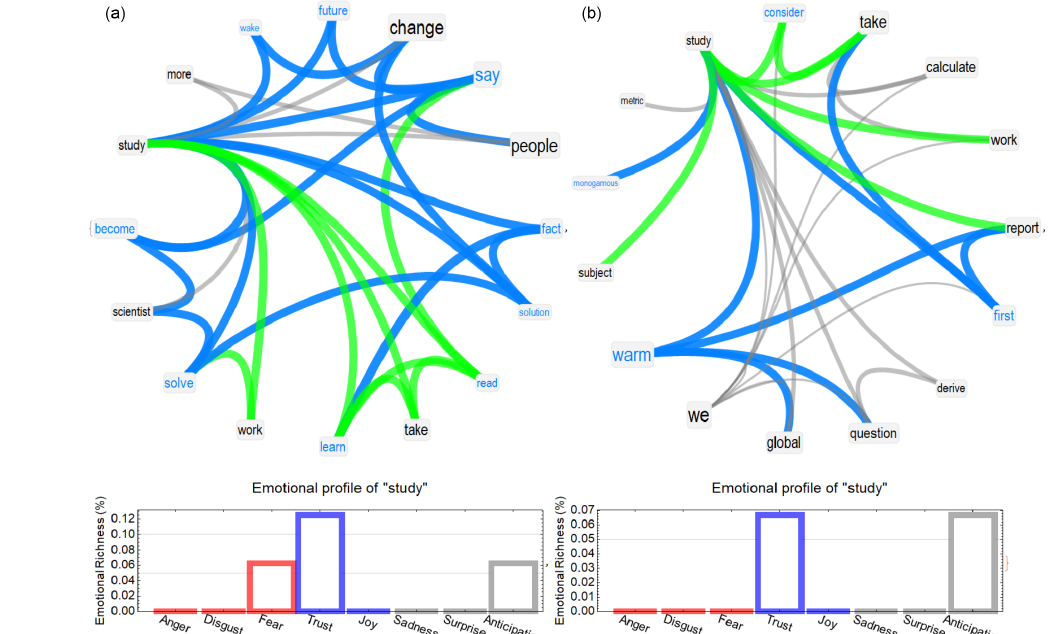
Figure A12. Speakers’ mindset reconstruction around “study” in the speeches of Greta Thunberg (a) and Christopher Monckton (b) . We refer the reader to Fig. 1 for a detailed explanation of the colour code and to Lexicon 1 for an interpretation of the